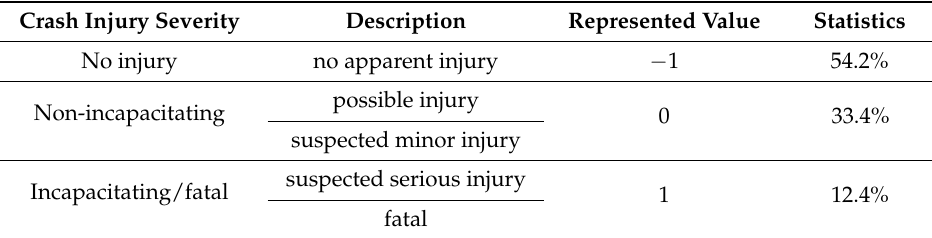
Table 3. Output variables of the crash injury severity.